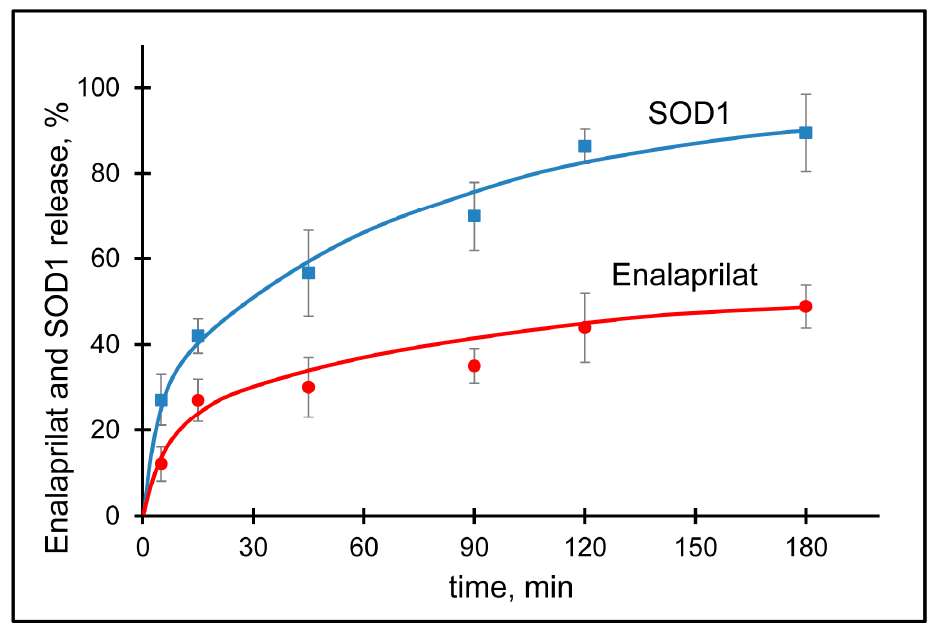
Figure 3. Elution of enalaprilat (red) and SOD1 (blue) from CaP-nanoparticles covered with 5 kDa chitosan in 0.15 M NaCl, pH 7.5.